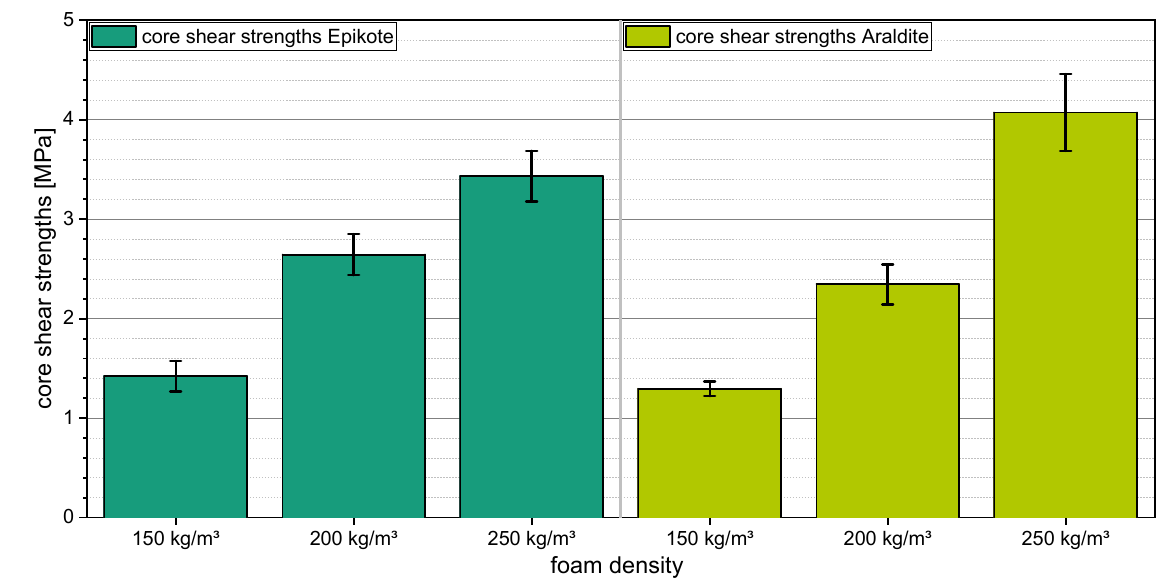
Figure 8. Core shear strength of the sandwich structures for the Epikote resin system (left) and the Araldite resin system (right).